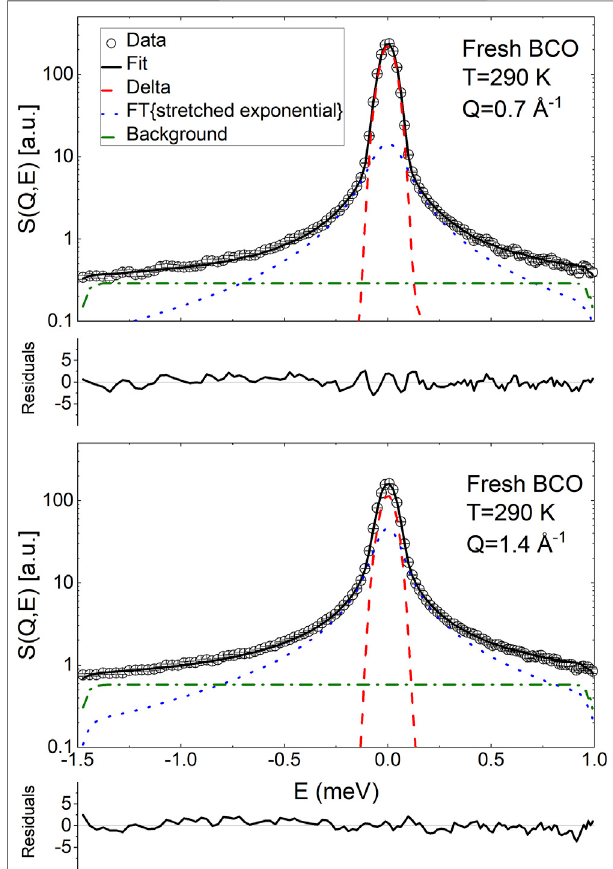
FIGURE 4 | Exemplary fi t of the QENS spectra of fresh BCO using Eq. 20 at two Q values. The normalized residuals ( exp data − fit an indication of the quality of the fi